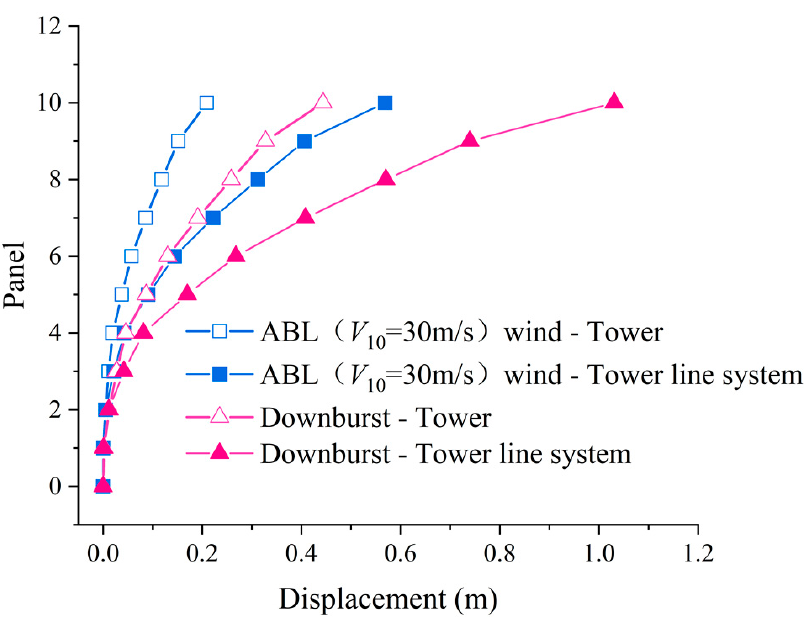
Figure 9. Displacement comparison of transmission tower ( V 10 = 30 m/s).